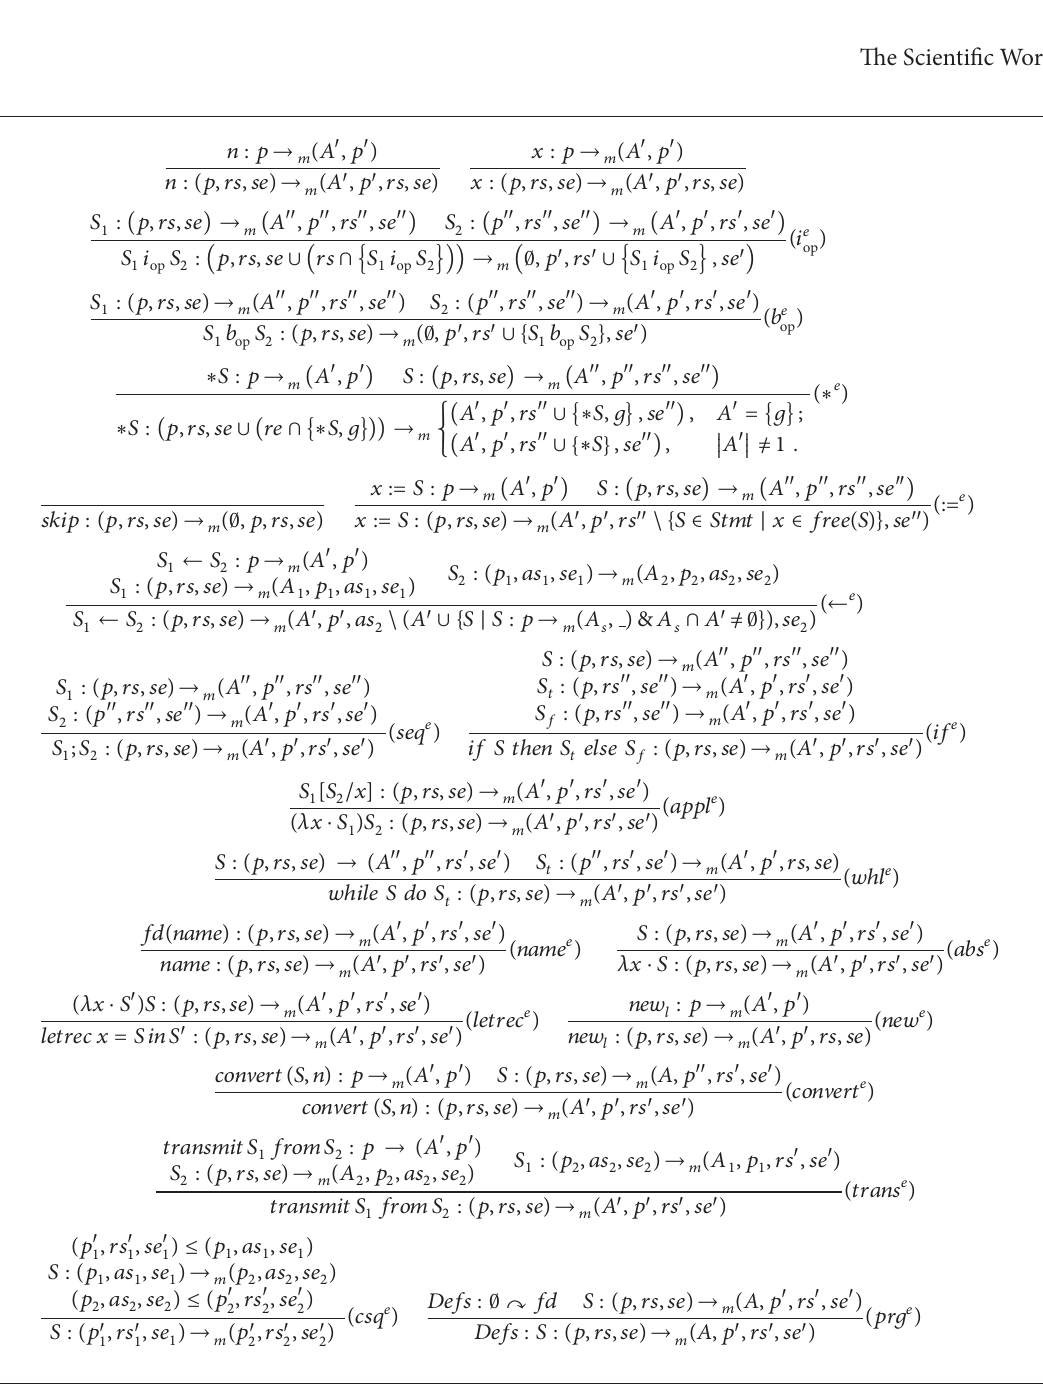
Algorithm 2: Inference rules of the semiexpectation type